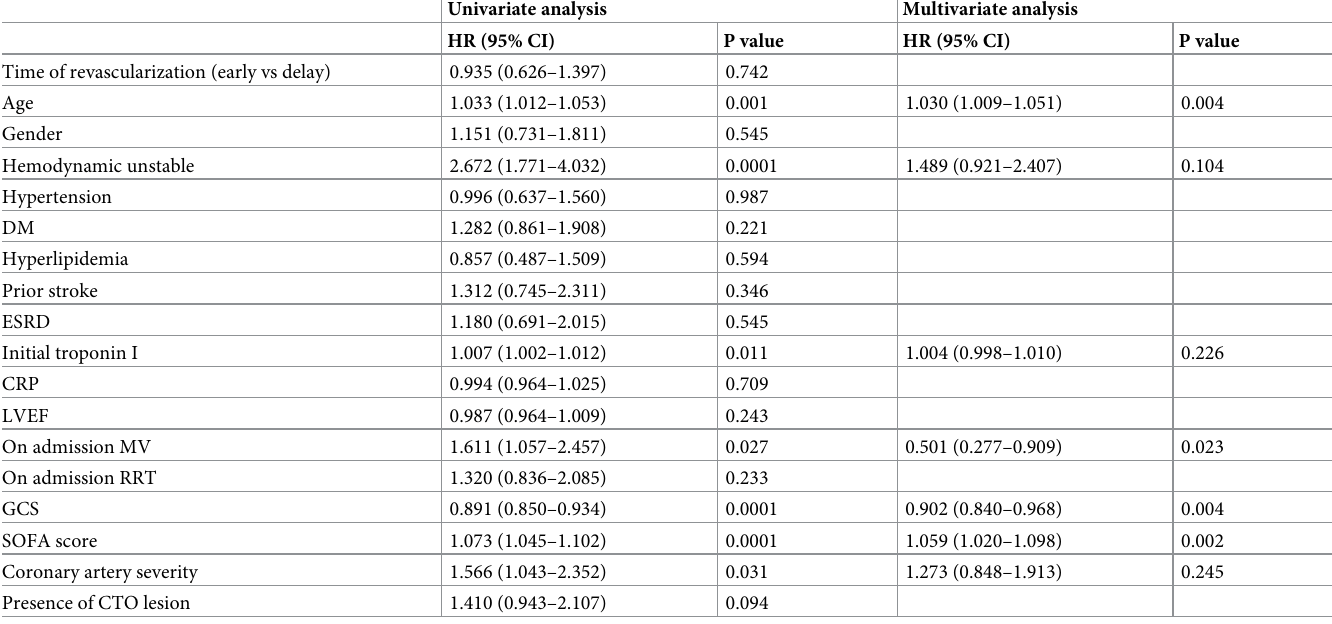
Table 4. Univariate and multivariate analysis of risk factors of one-year all-cause mortality. Univariate analysis Multivariate